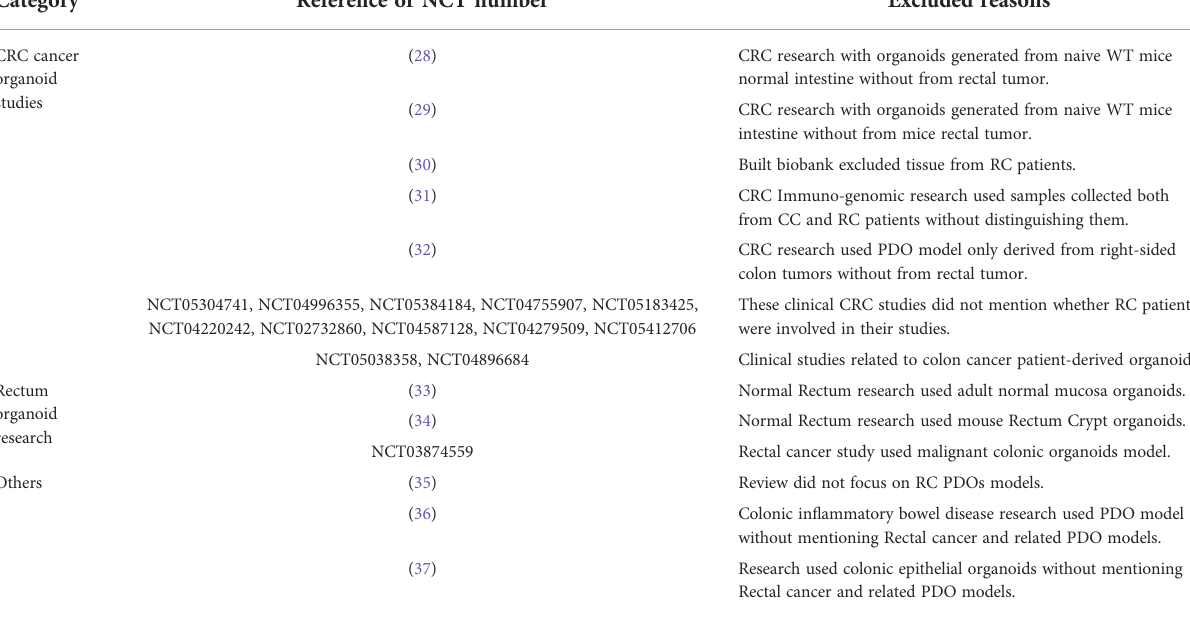
TABLE 1 Excluded records of the CRC cancer organoid studies, rectum organoid research and